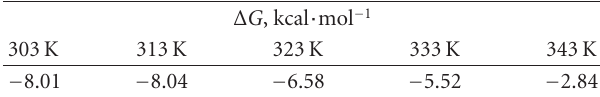
Table 7: The Free energy of adsorption ( Δ G ads ) for carbon steel in 1.0M HCl in the presence of the aqueous extract of Neem leaves at various temperatures (303K − 343 K).